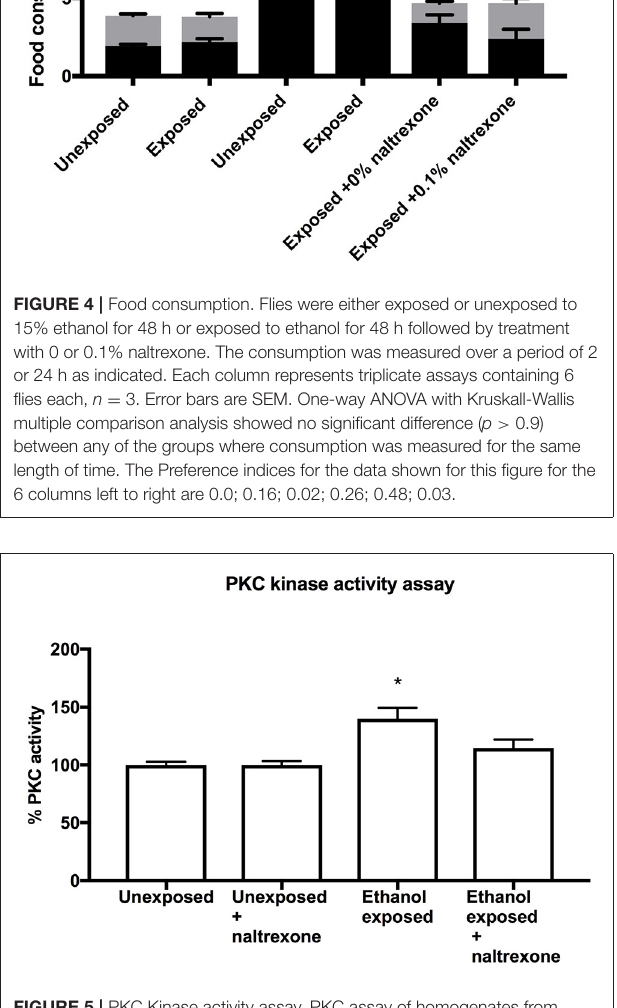
FIGURE 5 | PKC Kinase activity assay. PKC assay of homogenates from heads of flies exposed to food for 72h (Unexposed), exposed to food for 48h and treated with naltrexone for 24 h (Unexposed + naltrexone) exposed to ethanol for 48h and food for 24h (Ethanol exposed) or exposed to ethanol 48h followed by naltrexone for 24h (Ethanol exposed + naltrexone). Each bar represent two independent experiments each consisting of triplicate assays containing 15 fly heads each. n = 6. Error bars are SEM. Data was analyzed by non-parametric one way ANOVA Kruskal-Wallis with post-hoc comparison to Unexposed flies. The only statistical difference was between Unexposed and Ethanol exposed * p =